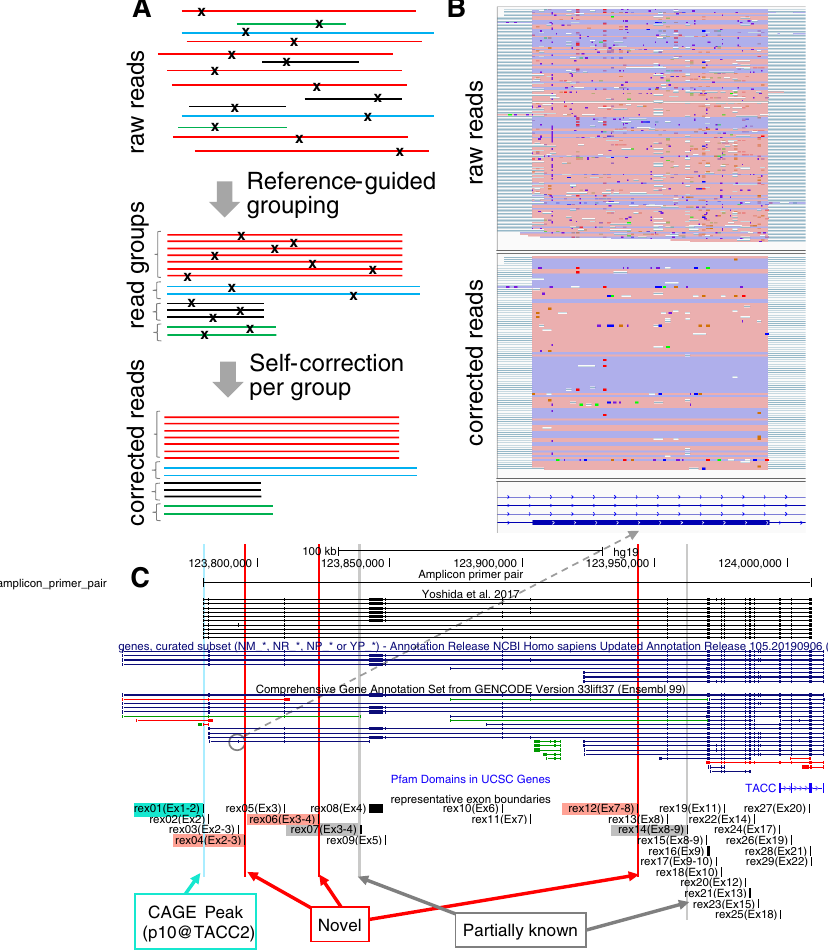
Figure 2. Sequence error correction and identified exons. ( A ) Schematic representation of sequence error correction. Individual lines with the same color indicate the same isoform, where “x” indicates sequence errors ( B ) Sequence matches and mismatches in the alignment before and after sequence error correction, shown in IGV. The pink and blue regions indicate forward and reverse aligned blocks between the reads and the genome. A minor exon, comprising a Gencode gene model ENST00000491540, is shown (referred as rex04). ( C ) The 29 identified exons: rex01 to rex29. Novel exons are colored by